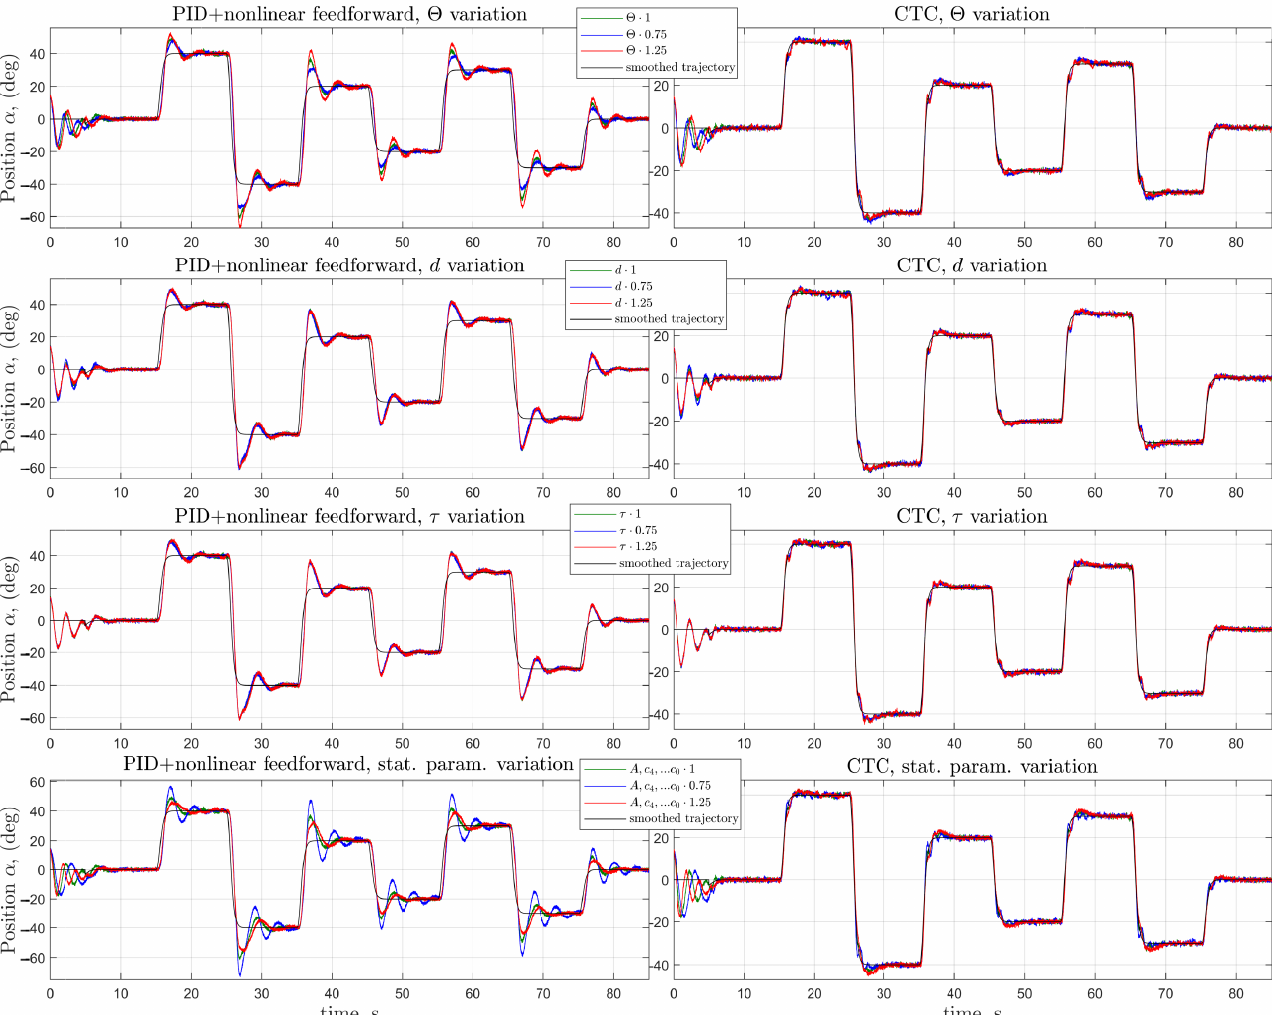
Figure 16. Simulation studies for investigating robustness and model parameter sensitivity; for CTC cases Λ = 2.25 s − 1 ; for “PID with nonlinear feedforward” cases, the PID parameter set is from Table 3, A , c 0 , c 1 , c 2 , c 3 , c 4 values used in every case inside the CTC controller are from Table